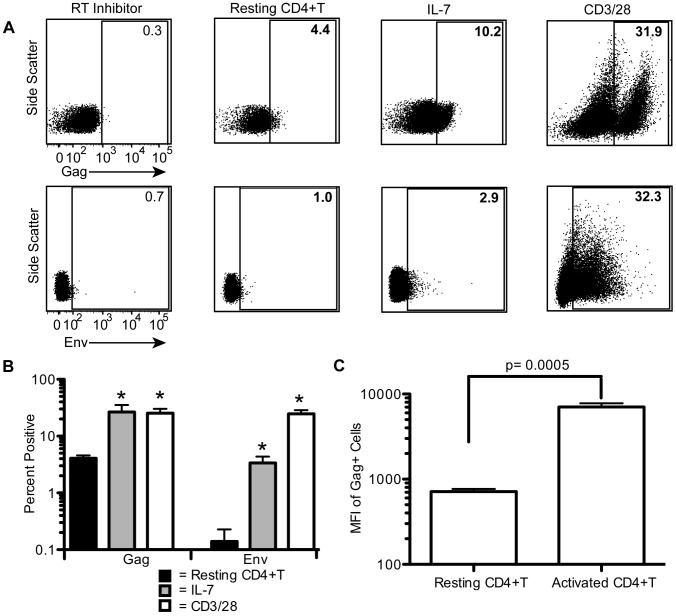
Resting CD4+T cells produce Gag but barely detectable levels of Env Cells were infected as in Figure 1 (MOI of 3) in the presence of 8 µg/mL polybrene.Cells were cultured in the presence of 25 µg/mL anti-CD4 clone 19, and Gag and Env protein levels were measured at 72 hours (48 hours in CD3/28 treated cells). A representative experiment is shown in A. An efavirenz control was used to control for background levels. The average of 3 experiments with 3 different donors is shown in B. The average MFI (median fluorescence intensity) of the Gag+ cells in resting and CD3/28 activated cells is shown in C. Error bars represent the standard error of the measurements. *Statistically significant at p<0.05 level.